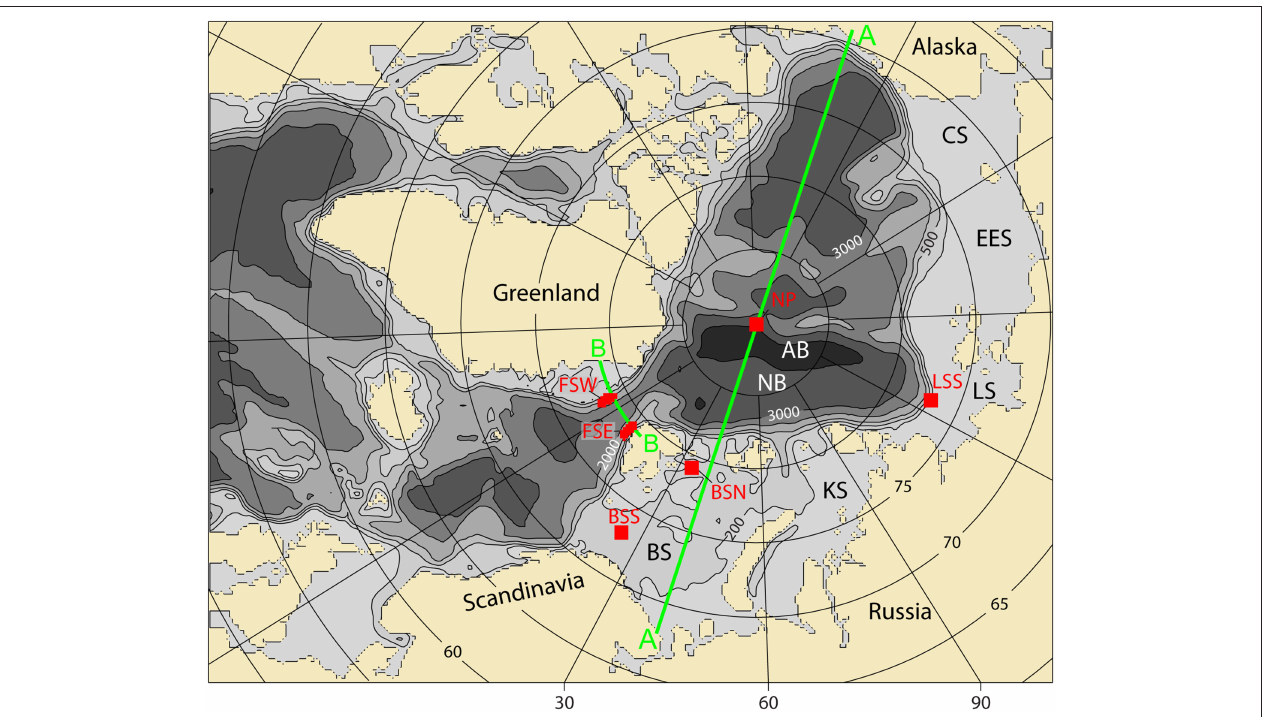
FIGURE 2 | The model domain. BS, Barents Sea; SB, Spitsbergen; KS, Kara Sea; LS, Laptev Sea; ESS, East Siberian Sea; NB, Nansen Basin; and AB, Amundsen Basin. The transect line A (blue) indicates a cross Arctic Ocean transect. The transect line B (red) indicates a cross Fram Strait transect. The boxes indicate regions of 25 grid points that are investigated through a time series analysis: FSW, Fram Strait West; FSE, Fram Strait East; BSS, Barents Sea South; BSN, Barents Sea North; LSS, Laptev Sea Shelf Break; and NoP, North Pole.